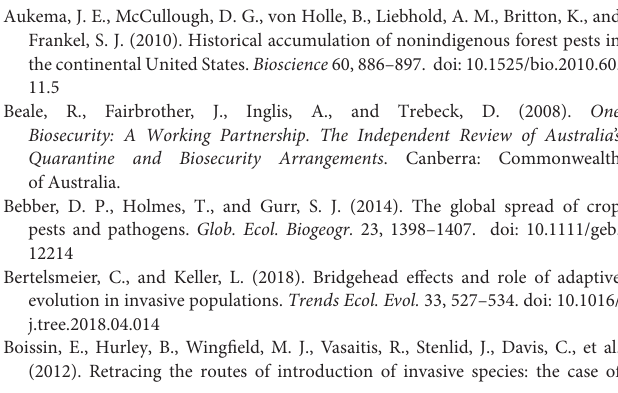
FIGURE S1 | Native range of non-native insect (Coleoptera = stippled; Hemiptera = black; other = striped) and fungal (gray) species established in Australia. Median year of detection from each region is also presented, with regions sharing same letters not differing significantly. FIGURE S2 | (A) Polyphagy (narrow host range, moderate host range, and broad host range) of non-native forest insect (Coleoptera = stippled; Hemiptera = black; other = striped) and pathogen (gray) species established in Australia. Median establishment year for each group is above the bars. (B) distribution of polyphagy (narrow, moderate, broad host range) among species ( n = 221) whose hosts are largely native (black) or largely exotic (gray). TABLE S1 | The list of 60 plantation, native, and amenity tree species used to generate the pest list. TABLE S2 | The list of non-native pest scientific and common names, and their year and state of first record, forest host genera, native range, and Australian and global invasive range